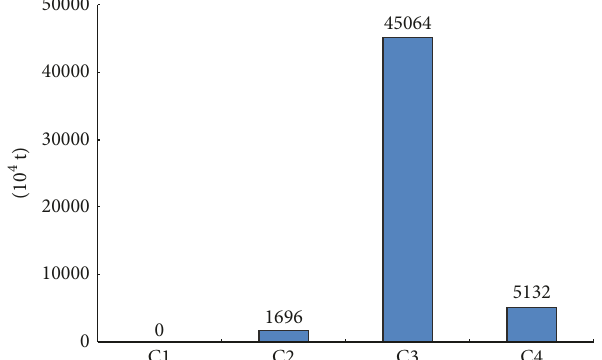
Figure 12: Proven oil reserves in different types of formation water in buried hill, Jizhong Depression.